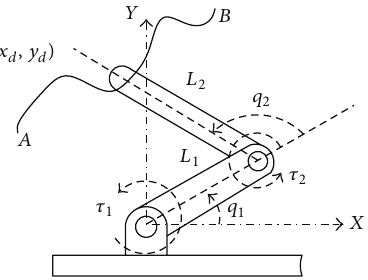
Figure 1: The structure of two-link robot